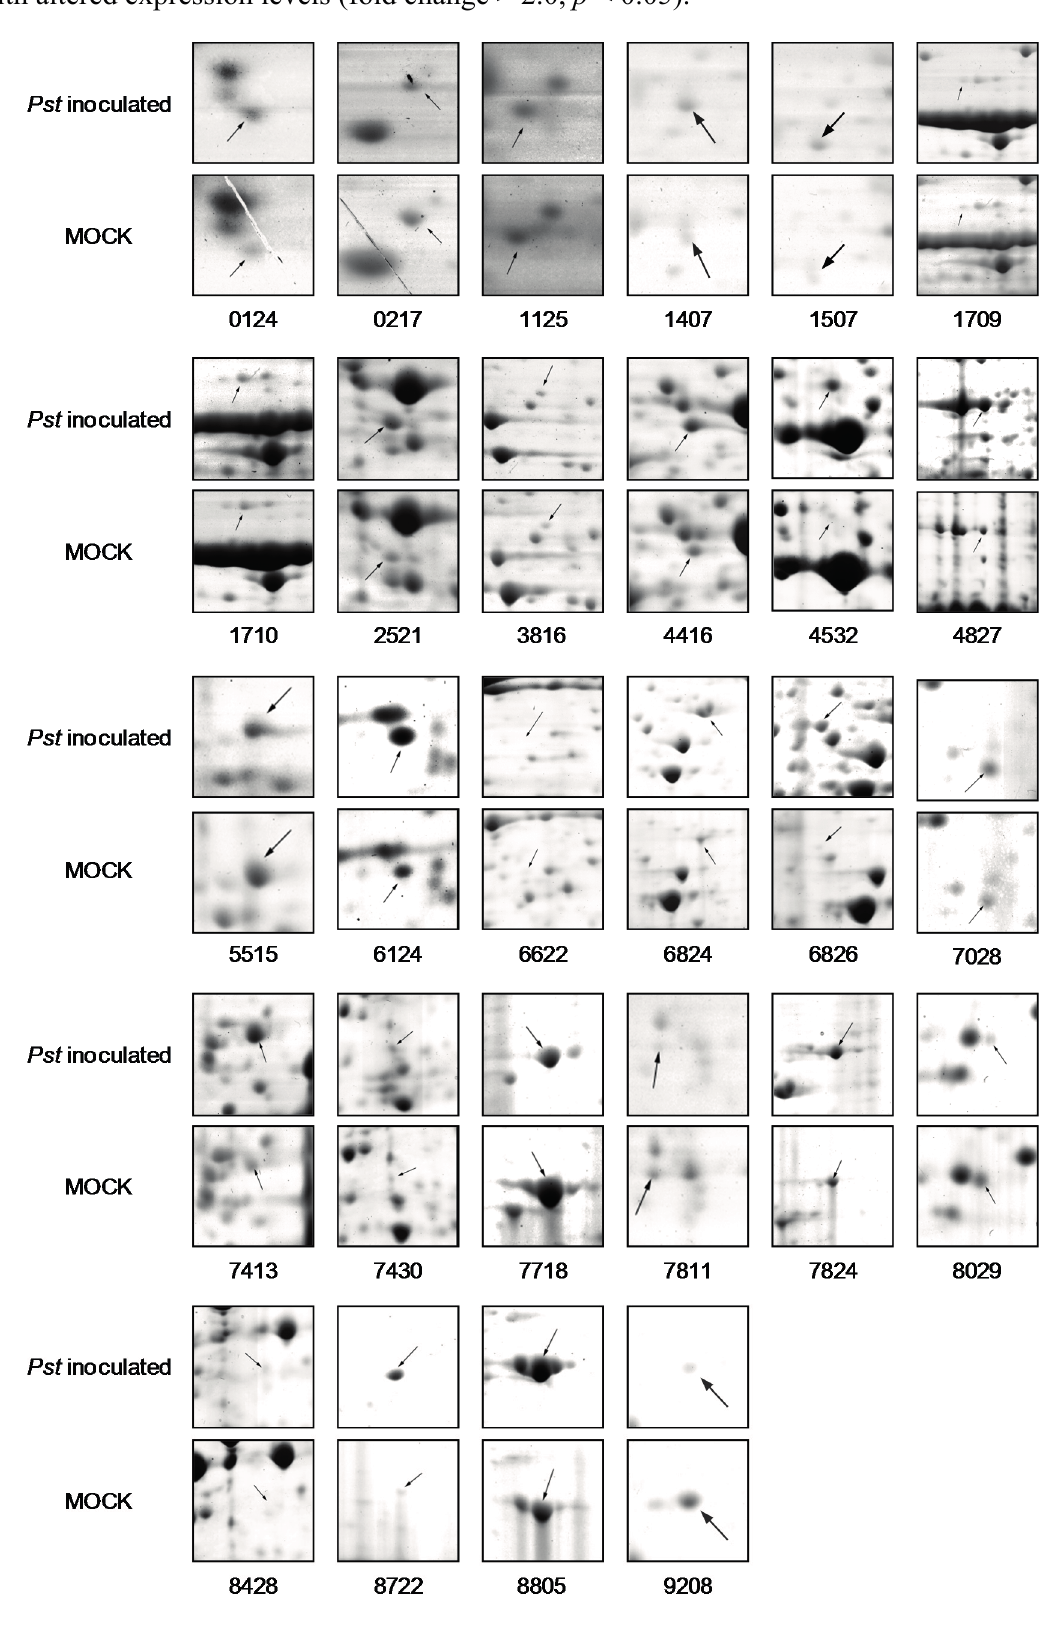
Figure 2. Differentially expressed proteins induced by Pst . Arrows point to protein spots with altered expression levels (fold change > 2.0, p <